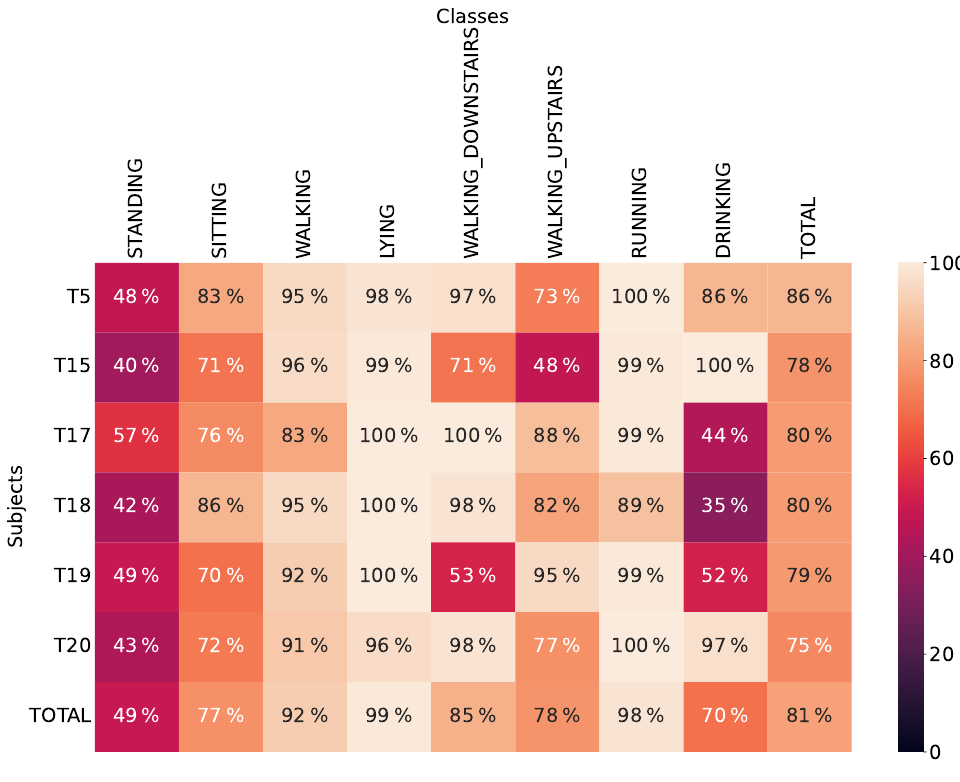
Figure 8. Accuracy per class and per subject for 80 filters per